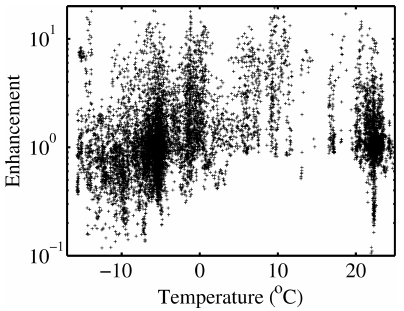
Figure 12. In-cloud CN enhancements of BASE-I and BASE-II, normalized by the enhancement values of the SMAI at each data point. Data from all PLOWS and ICE–T campaign flights; atmo- spheric conditions: temperatures – − 5–1 ◦ C; cloud droplet mean di- ameter – 5–25µm; drizzle concentration – <300L − 1 ; drizzle mean droplet diameter – <600µm; aircraft true airspeed – 125–150ms − 1 ; LWC – 0–0.4gm − 3 ; DWC/TWC – 0–1.